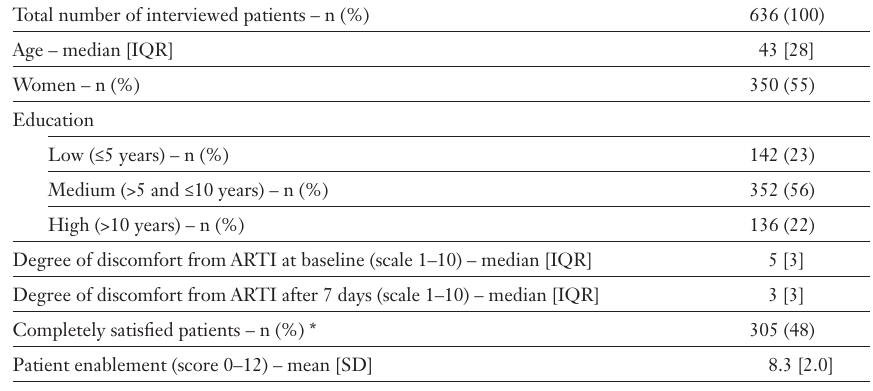
Characteristics of interviewed patients with ARTI.